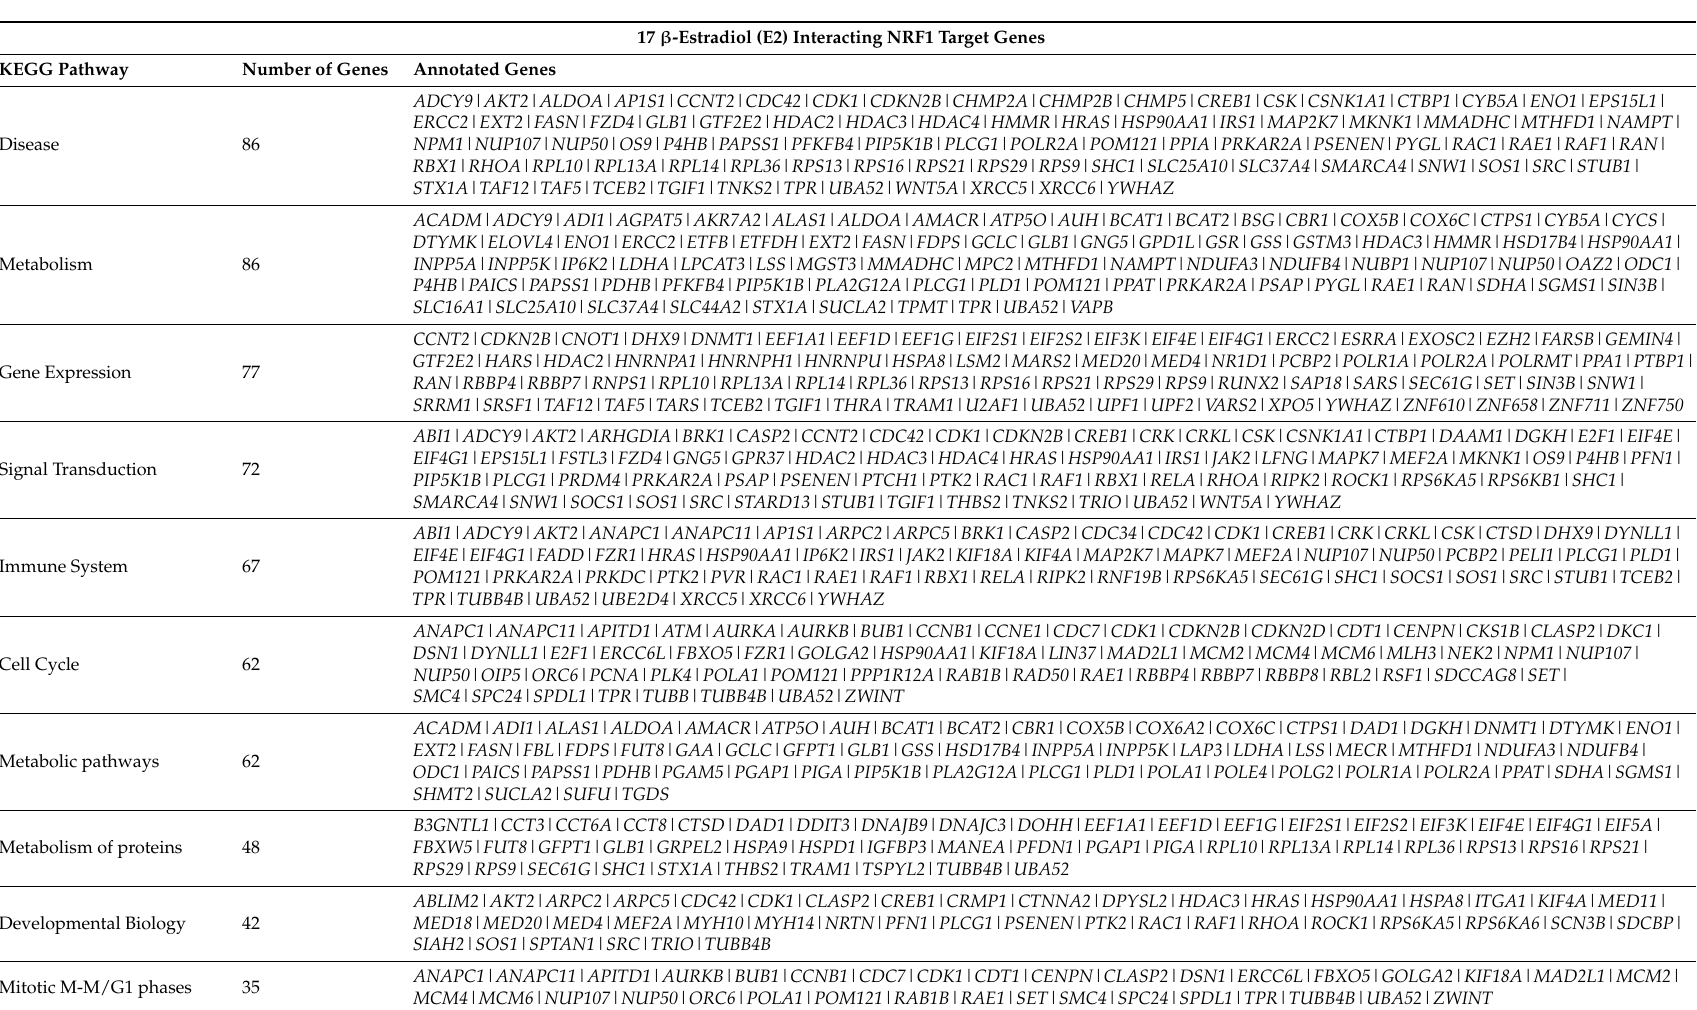
Table 4. Top 10 enriched pathways for E2 and NRF1-Target genes associated with estrogenic endocrine disruptors—BPA, PCB, phthalates, As, Cd, and